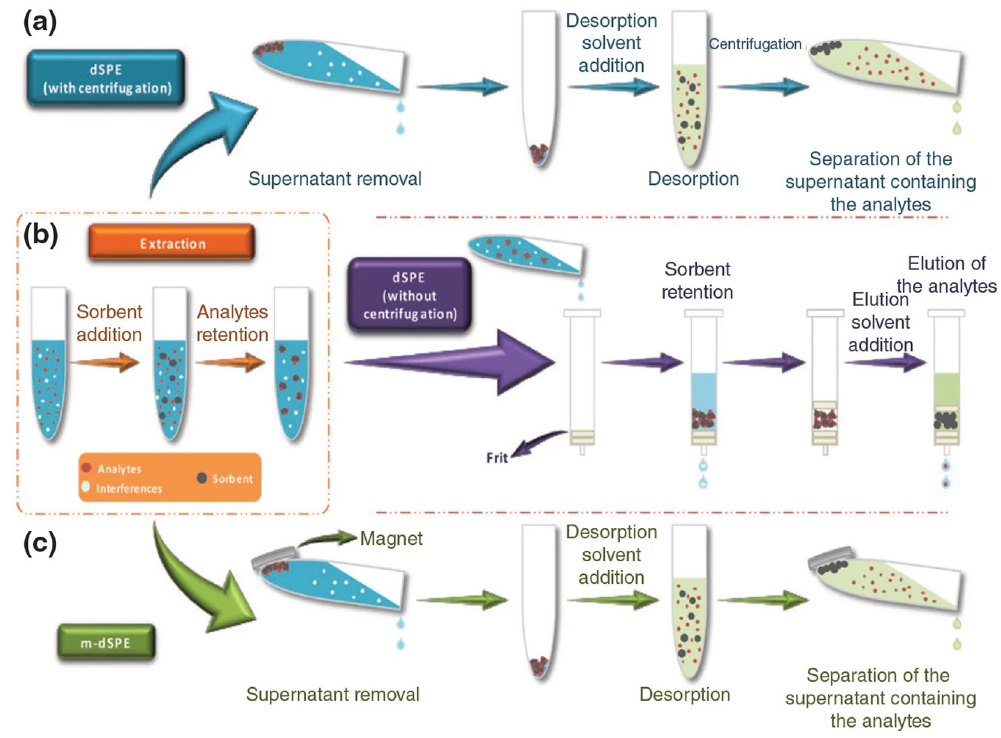
Figure 1: ( a ) Dispersive solid phase, ( b ) dispersive solid phase without centrifuge, and ( c ) magnetic solid phase ( m - dSPE ) . Figure adopted from ref. [ 52 ]